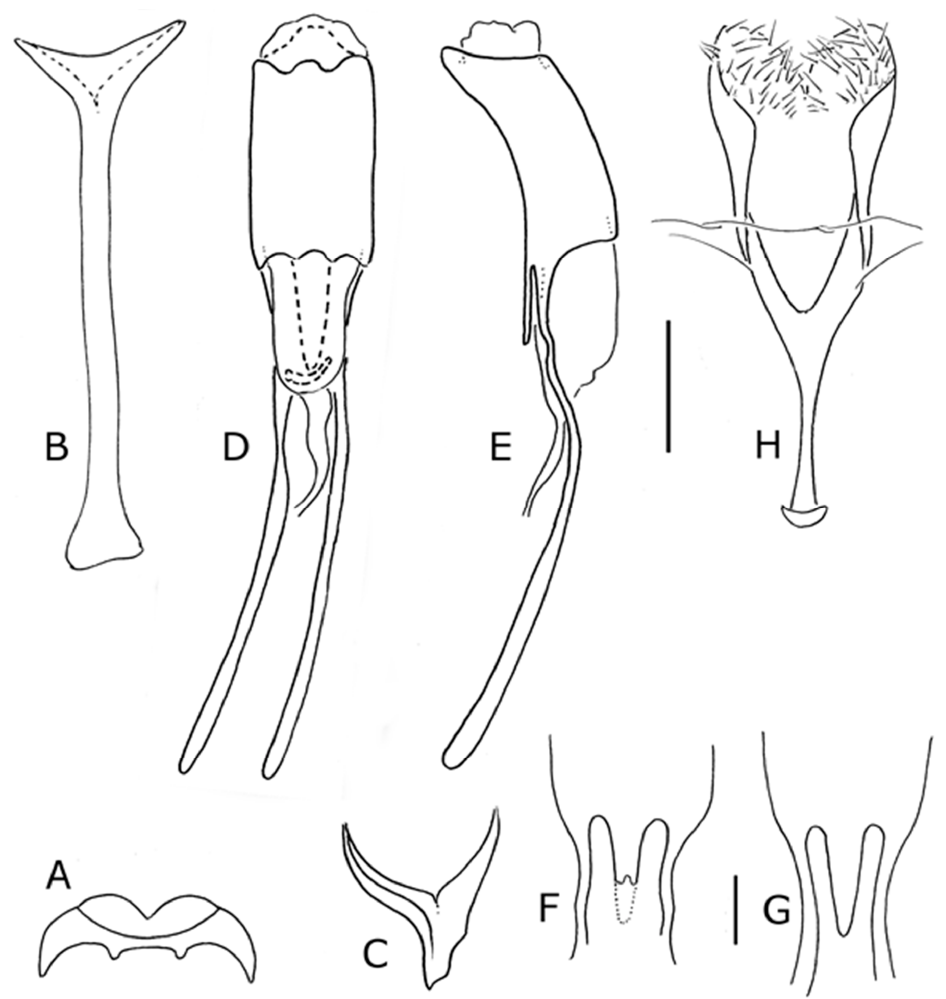
Figure 13. Sclerocardius bohemani Schoenherr, terminalia: ( A ) male sternite VIII, ( B ) spiculum gastrale, ventral, ( C ) tegmen, dorsal, ( D ) penis, dorsal, ( E ) penis, lateral, ( F ) penis, anterior ventral margin, showing truncated form of projection, ( G ) penis, anterior ventral margin, showing complete form of projection, and ( H ) female spiculum, ventrale ventral. Scales bars: ( A – E ) 1 mm, and ( F , G ) 0.5 mm.